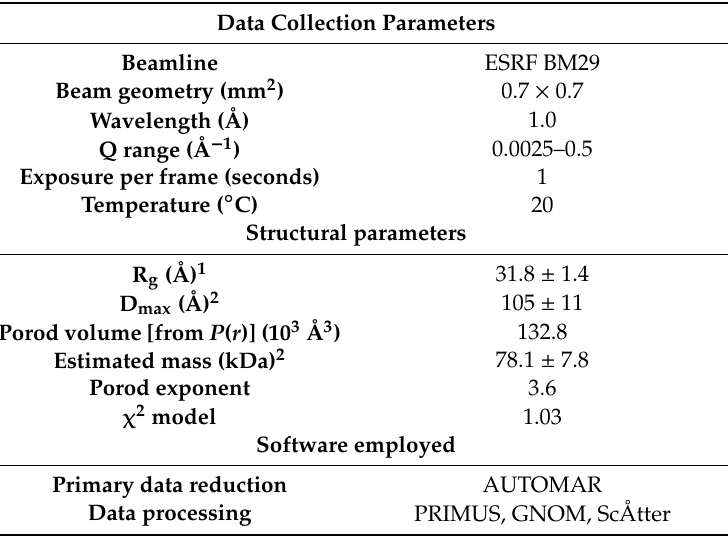
Table 1. SAXS data collection and